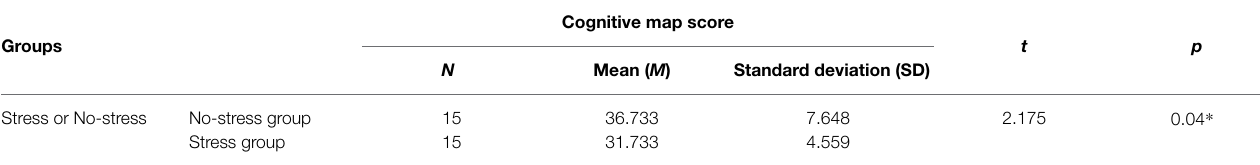
TABLE 4 | Cognitive map score: mean differences according to stress ( N = 30).